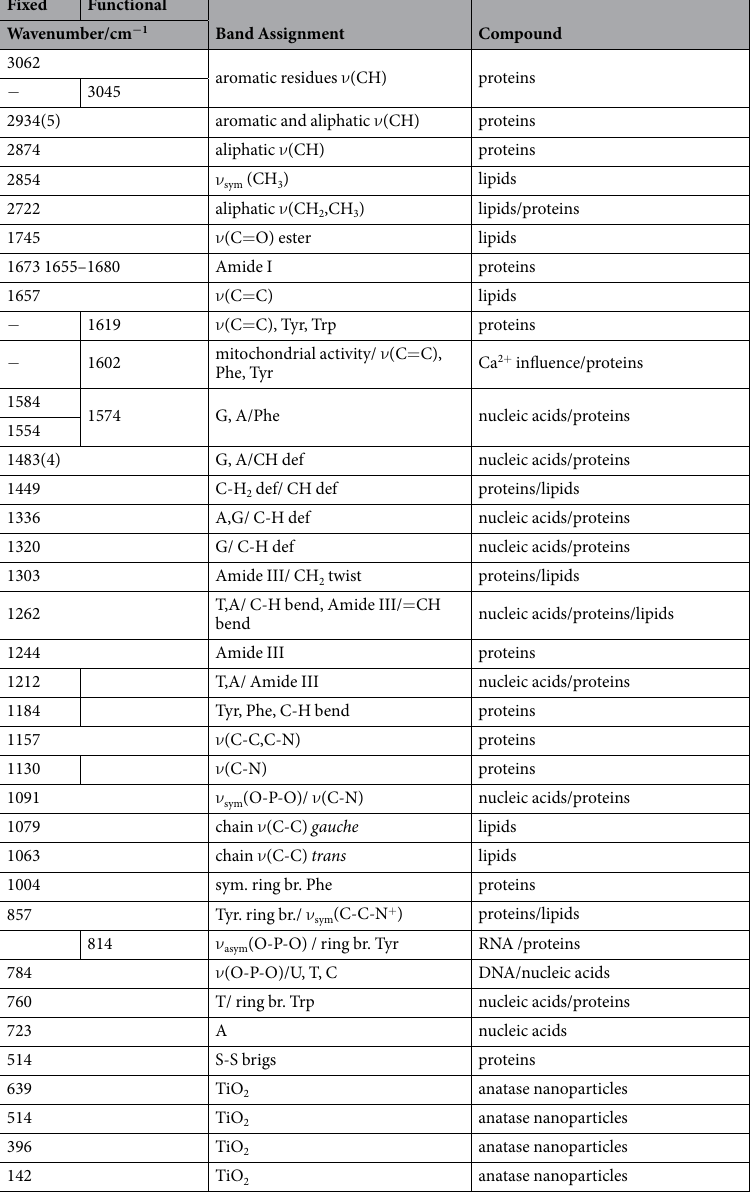
Table 1. Observed wavenumber values (cm − 1 ) for the most prominent bands of functional and fixed oocytes with assignments 8–12 obtained with the 532 nm laser line. a ν – stretching , def – deformation , br – breathing , sym – symmetric , asym – asymmetric , Phe – phenylalanine; Trp – tryptophan ; Tyr- tyrosine; T – thymine; A – adenine; G – Guanine; C – cytosine; U –